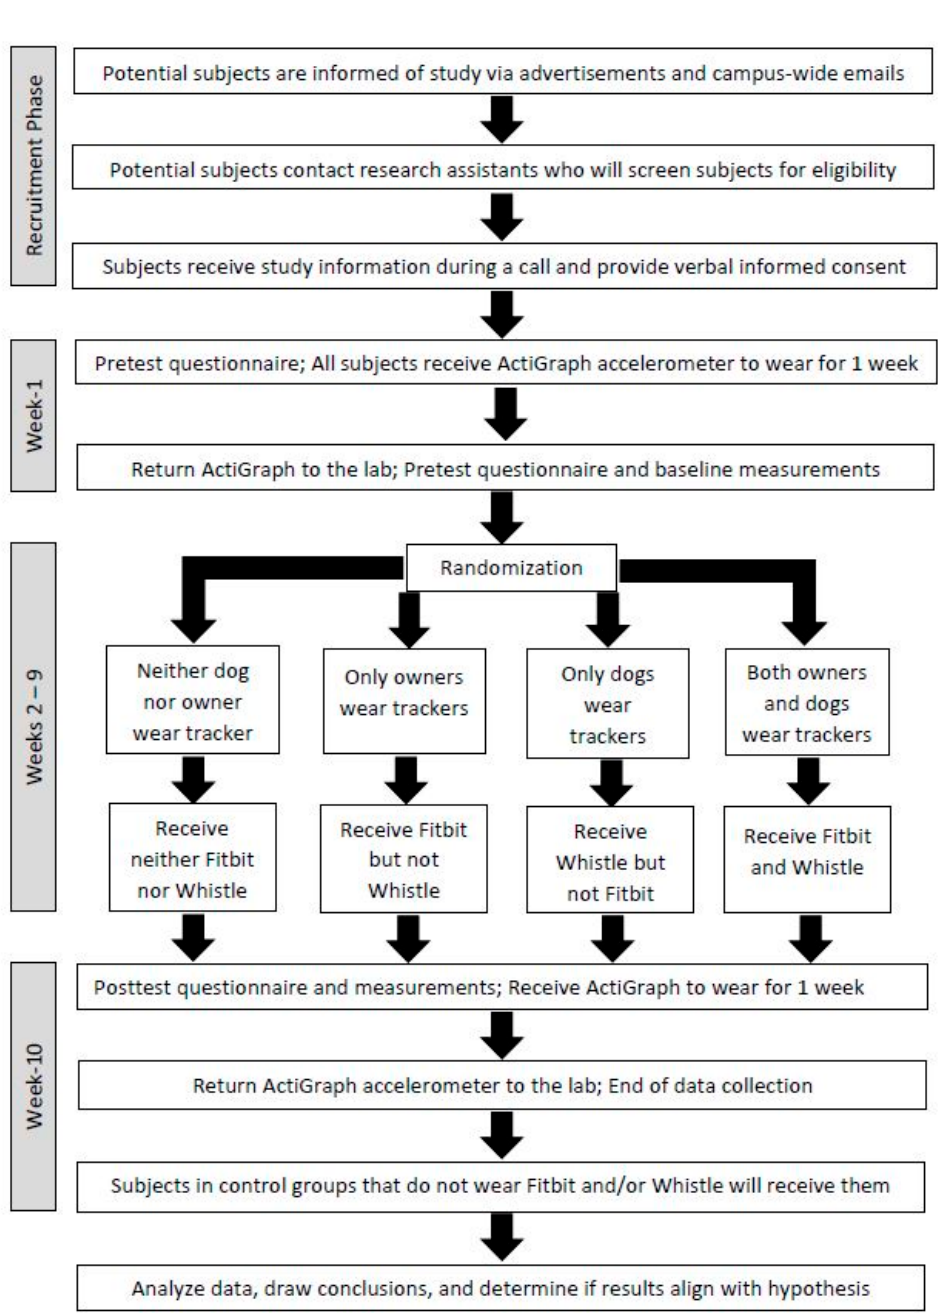
Figure 1. Flow Chart for 2 × 2 Factorial Randomized Trial on Use of Human and Dog Activity Trackers.